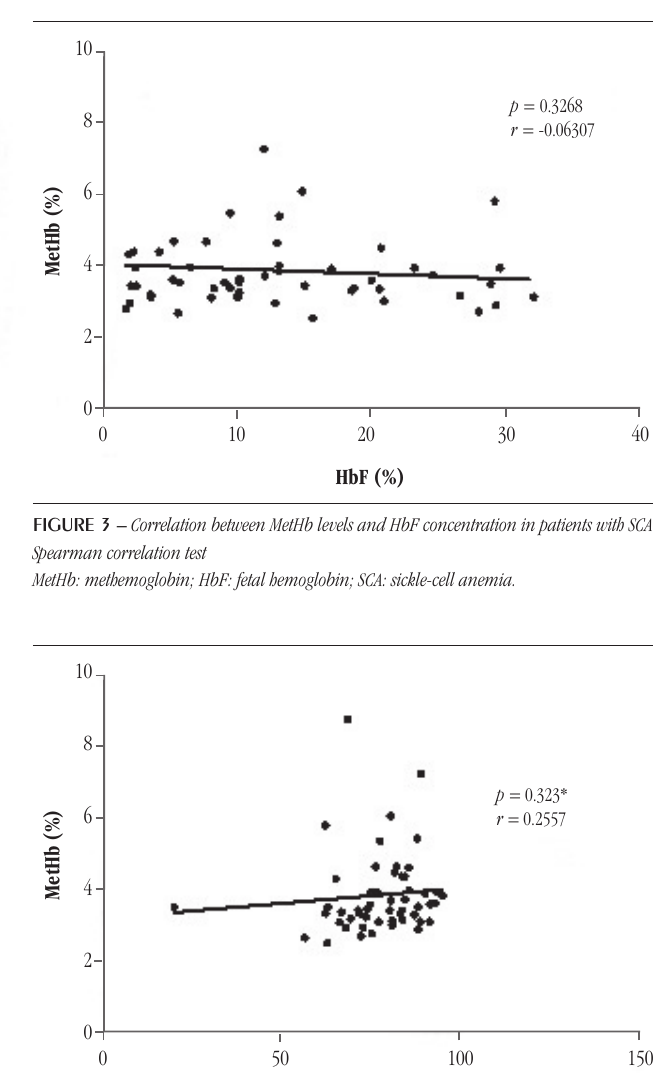
figurE 2 – MetHb levels in patients with SCA with and without HU therapy (SSHU and SS, respectively), and in the control group p value obtained by Kruskal-Wallis test. Statistically significant difference between groups SSHU and control group (HbAA), and SS and the control group (HbAA − healthy subjects); SSHU: patients with SCA treated with HU; SS: patients with SCA untreated with HU. Results presented as median. *Significant at the 0.05